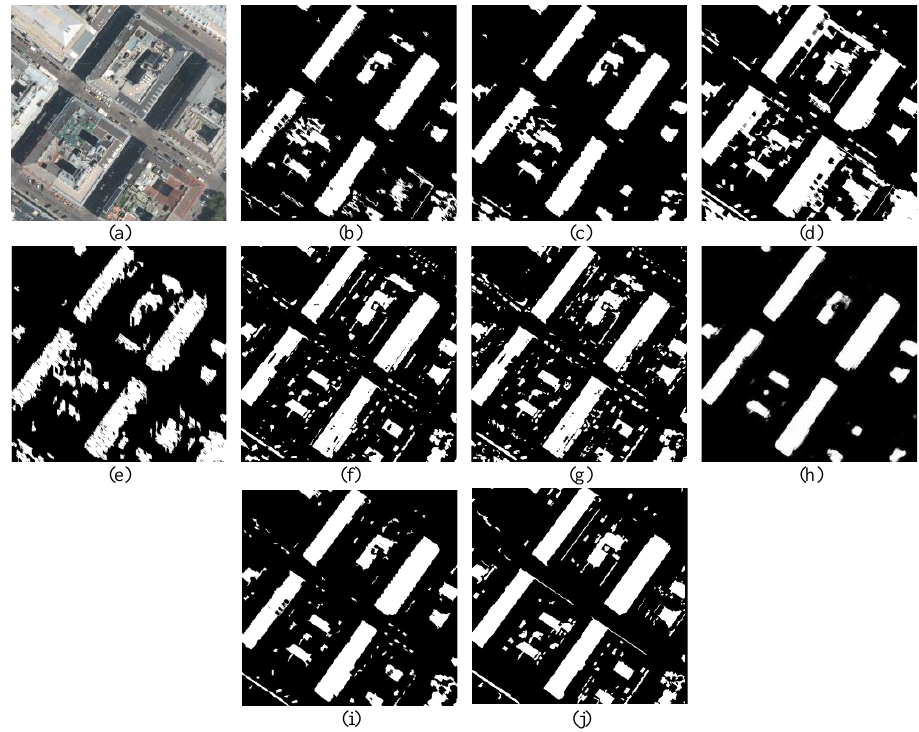
Figure 6. ( a ) Original image; ( b ) SRHI; ( c ) NB; ( d ) HTD; ( e ) C1C2C3; ( f ) U-Net method; ( g ) Segnet method; ( h ) BDRAR method; ( i ) DLA-PSO method; ( j ) ground truth. Table 3. Vienna shadow-test-evaluation index.